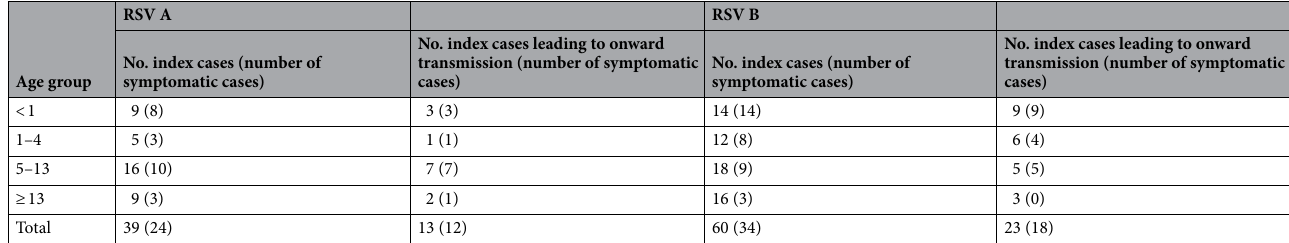
Table 1. Age distribution of index cases of household outbreaks. Index cases are clustered into 4 age groups and according to whether they led to onward transmission in the household or not .